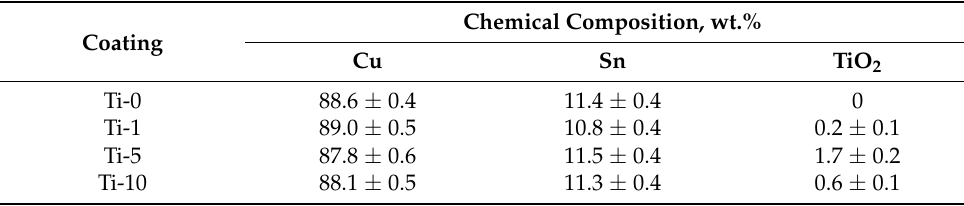
Table 2. EDX chemical composition (scans are 50 × 50 µ m 2 ) of Cu–Sn and Cu–Sn–TiO 2 coatings deposited from sulfate electrolyte with varying TiO 2